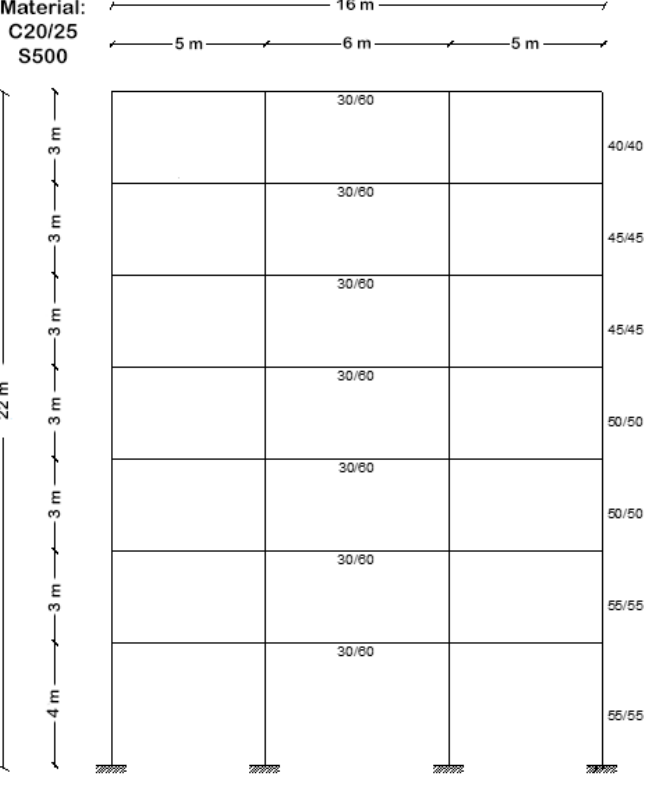
Table 2. T Statistical results of HHT-based seismic parameters. Parameters